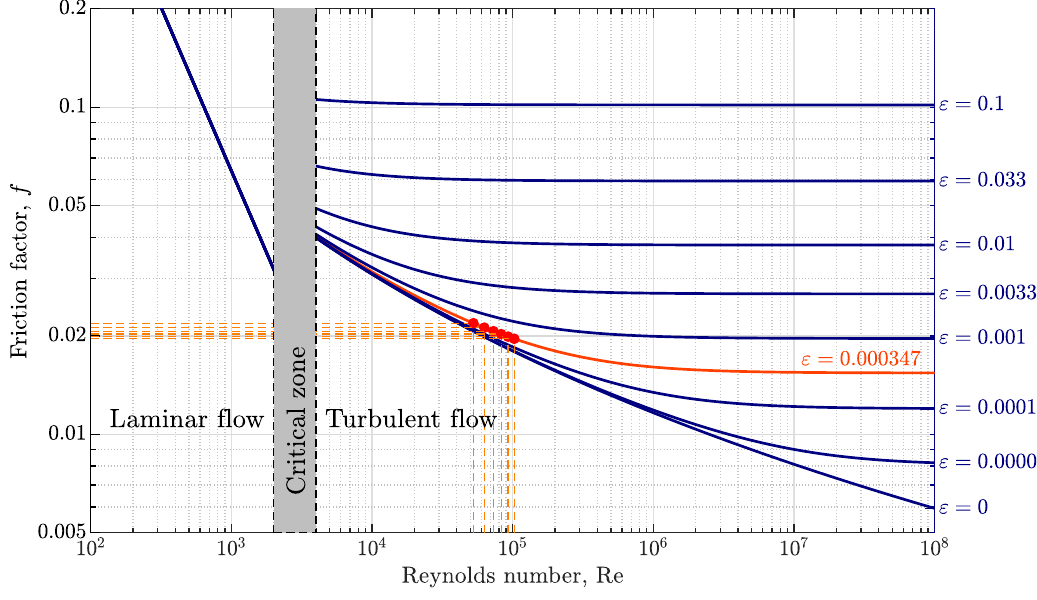
Figure 7. Moody chart with the parameters computed in the prototype